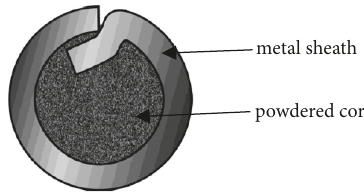
Figure 1: Schematic of a flux-cored